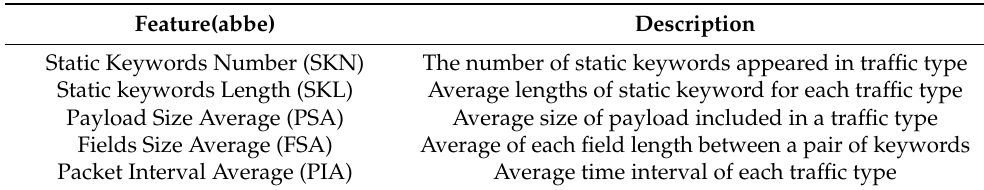
Table 2. Features used for rule